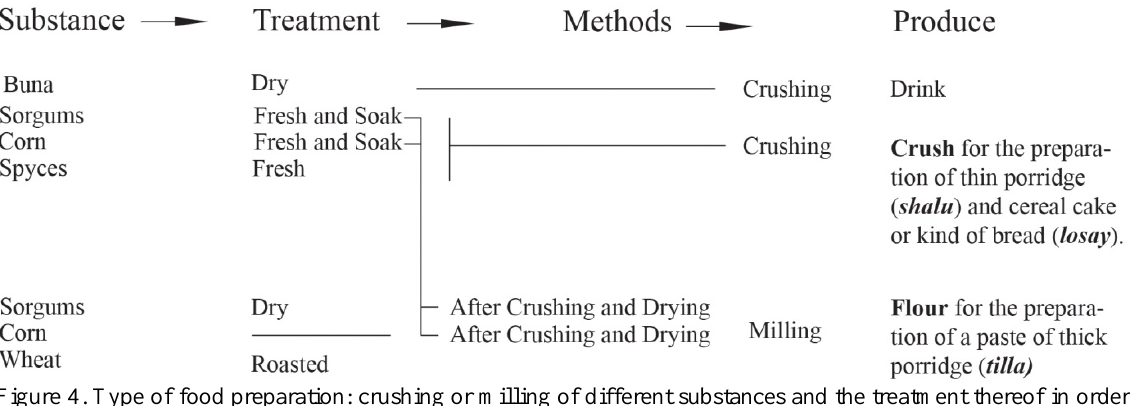
Figure 4. Type of food preparation: crushing or milling of different substances and the treatment thereof in order to make the final